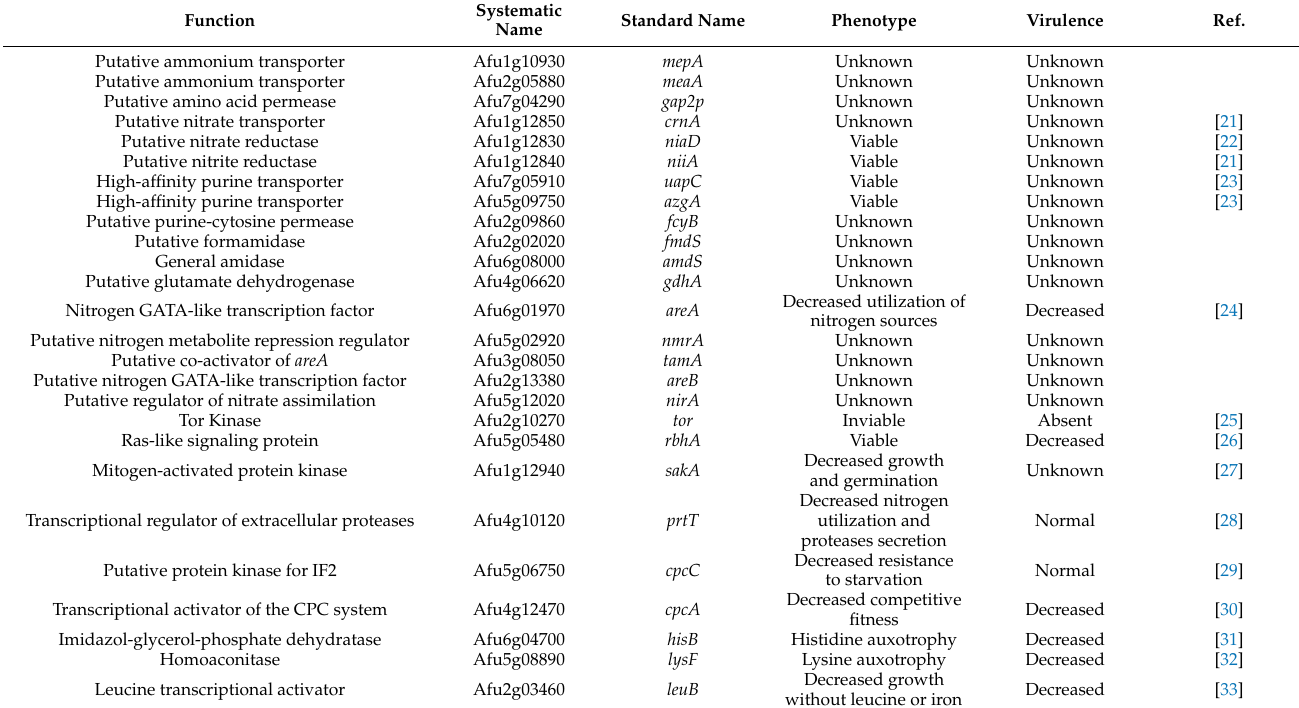
Table 1. A. fumigatus genes implicated in nitrogen metabolism and their implication for fungal phenotype and virulence.